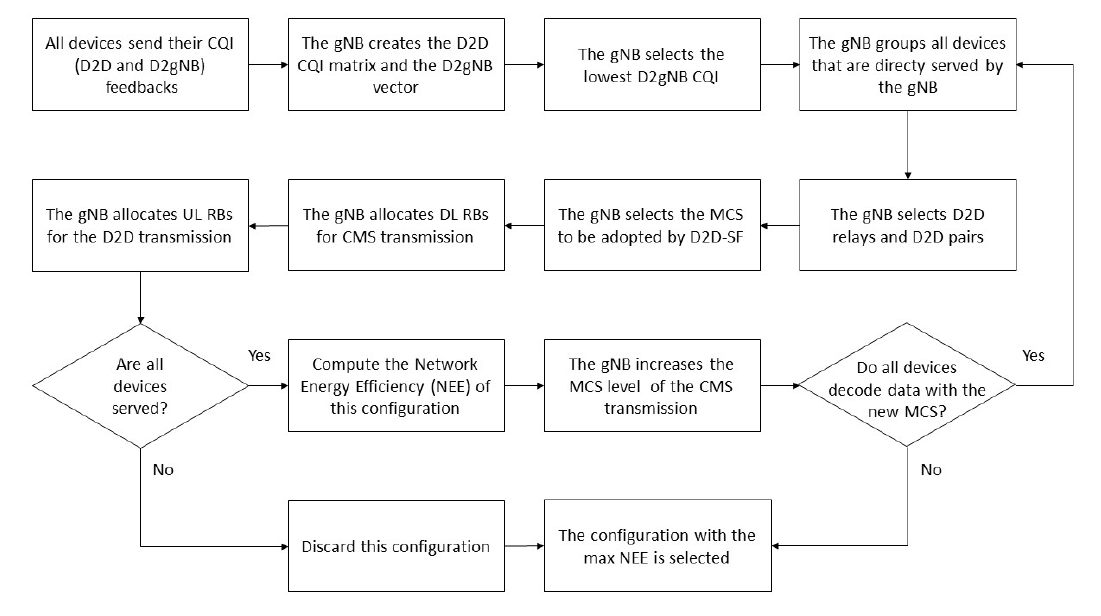
Figure 2. EED2D-SF flow